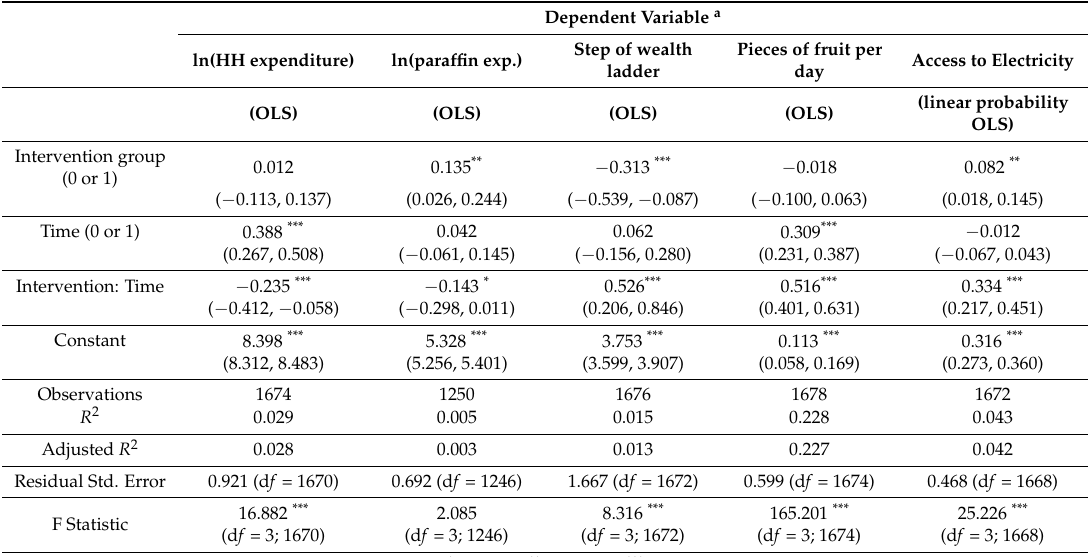
Table 1. Summary of ‘difference in difference’ model results from household surveys in 2012 and